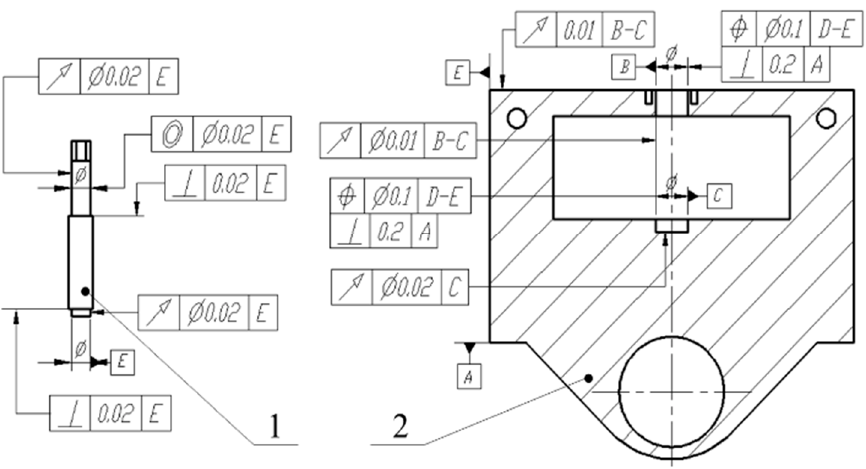
Figure 4. Part tolerances of thread fastening system. 1—Fastening bolt, 2—Cutter holder.